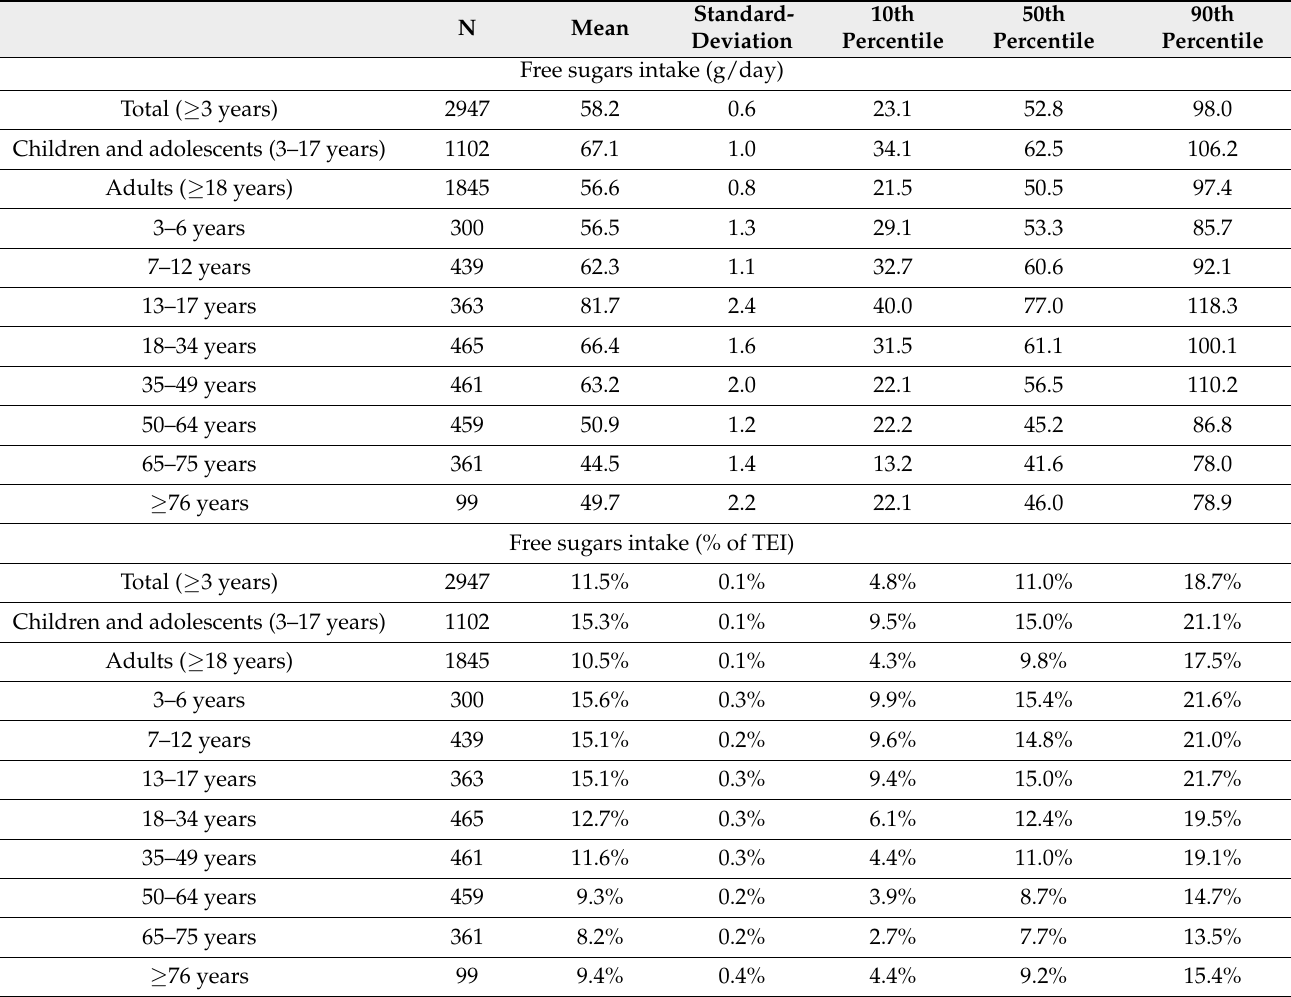
Table 2. Free sugars intake in children and adolescents as well as in adults (g/day and % of total energy intake (TEI)), stratified by